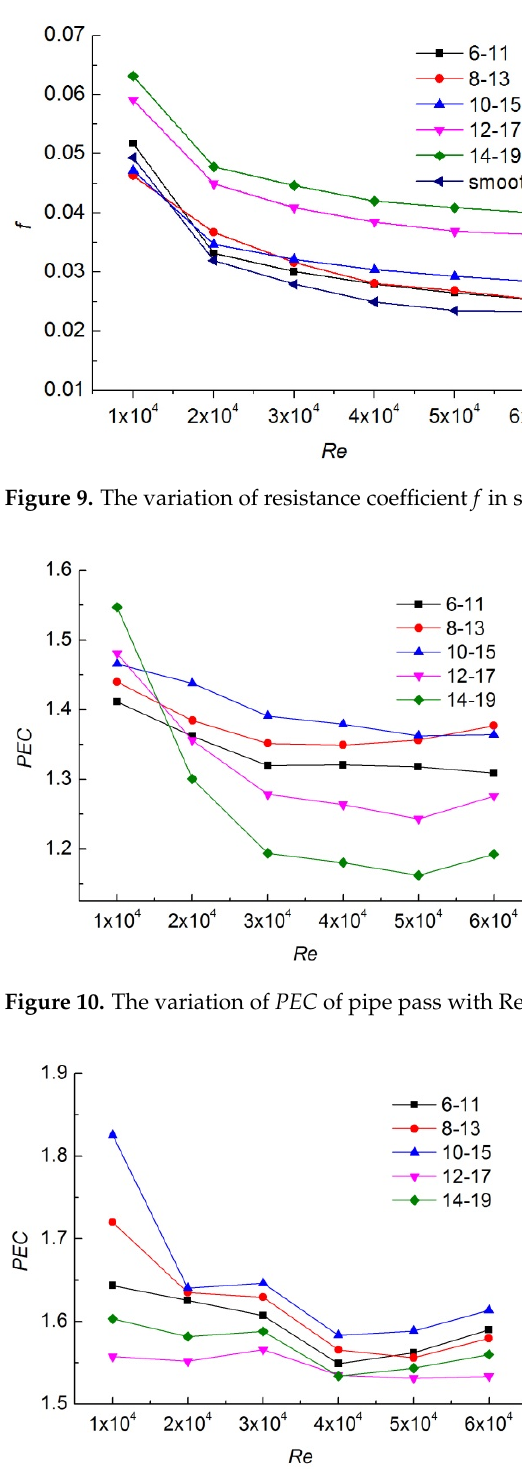
Figure 9. The variation of resistance coefficient f in shell with Re.